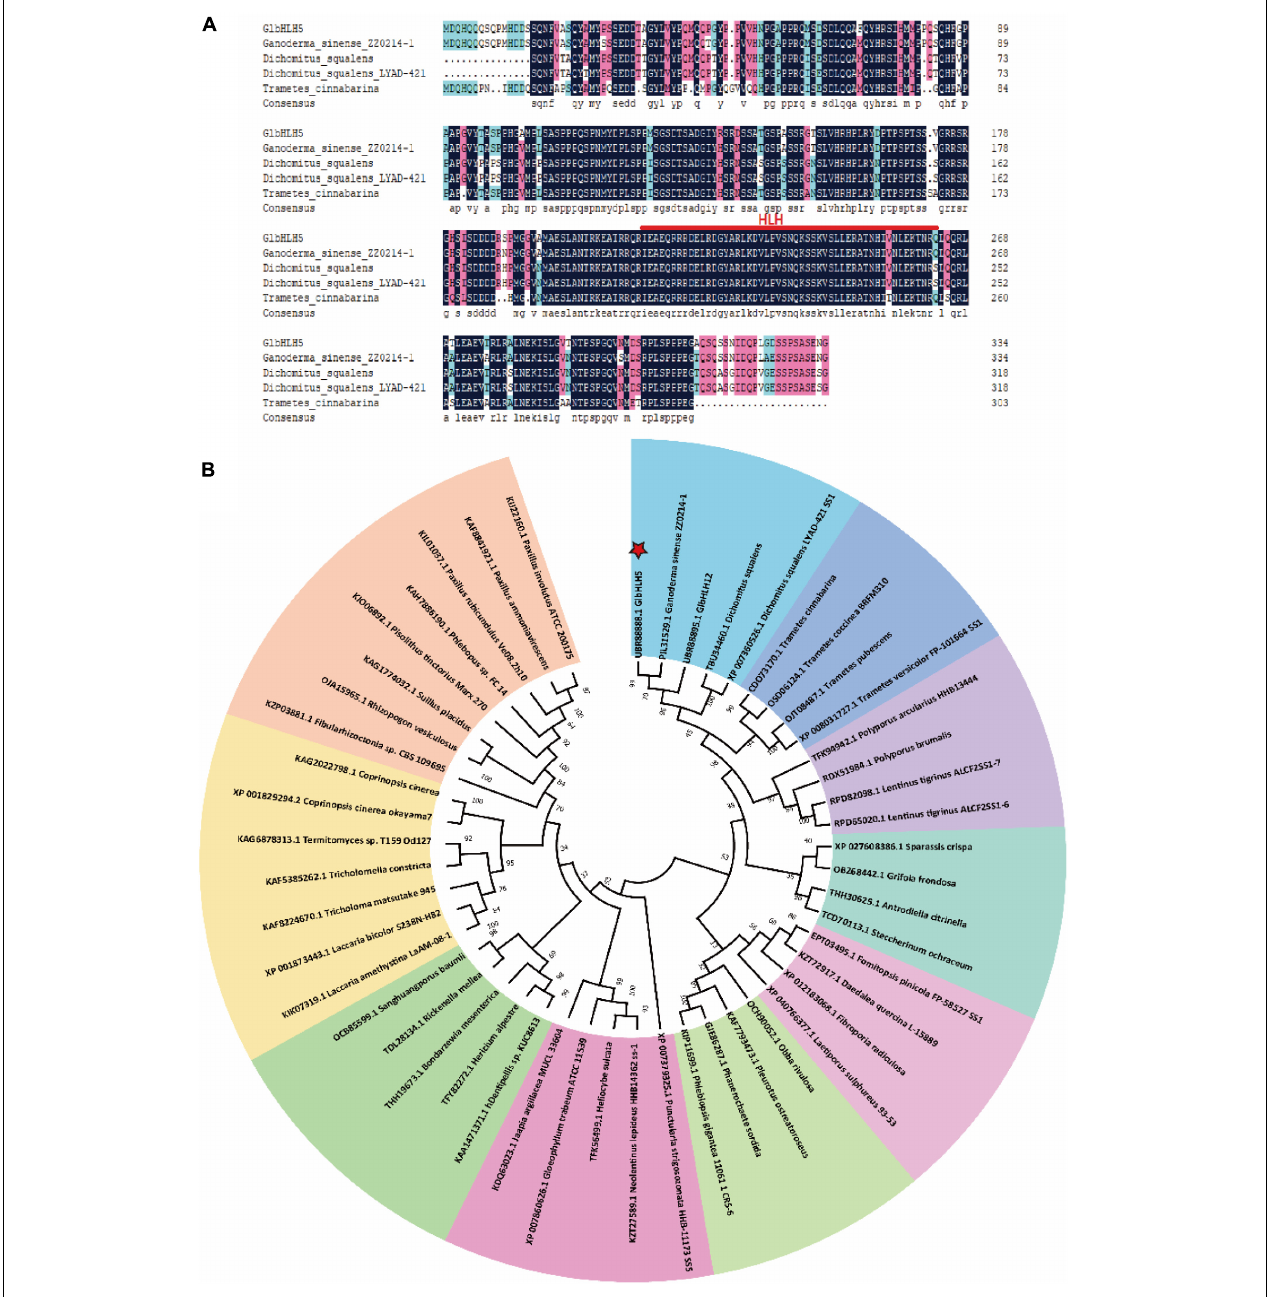
FIGURE 1 | Bioinformatics analysis of GlbHLH5. (A) The comparison analysis of the amino acid sequence of GlbHLH5 and other homologous proteins. (B) The adjacent tree of protein homologs, the percentage value of the leader program for 1,000 repetitions is displayed at the branch point.